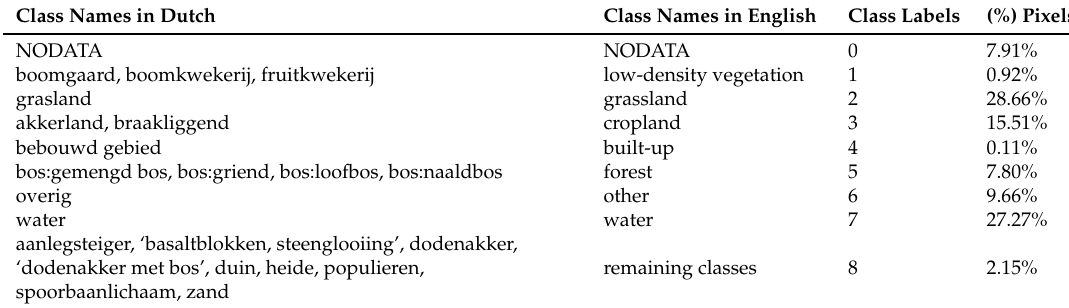
Table 1. Re-classification of the 22 original features of the INSPIRE TOP10NL data set.